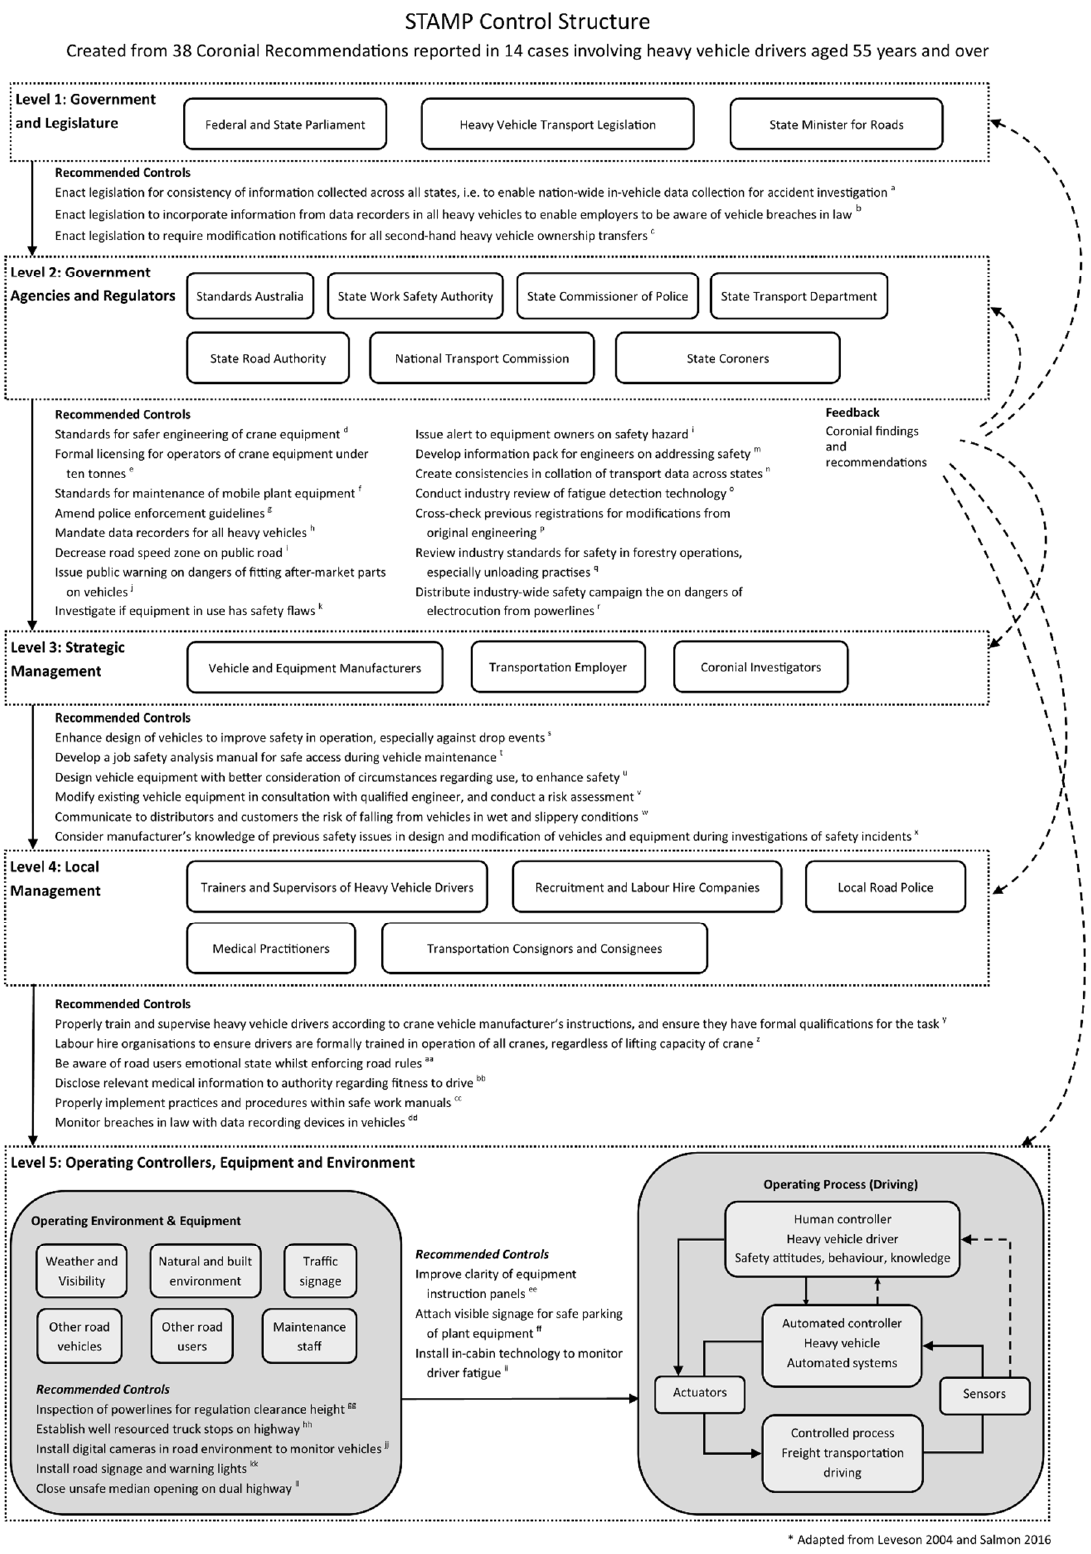
Figure 2. STAMP control structure of coroners’ recommendations for the road freight transportation industry (collective case study). * This figure is adapted from Leveson (2004) [54] and Salmon et al. (2016) [69].